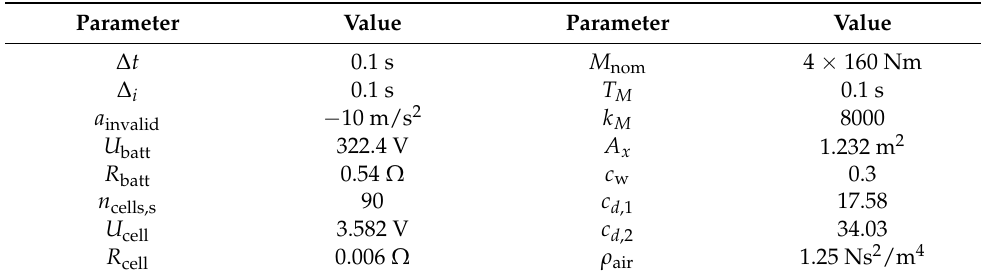
Table 1. Vehicle model parameters and general CACC problem parameters.